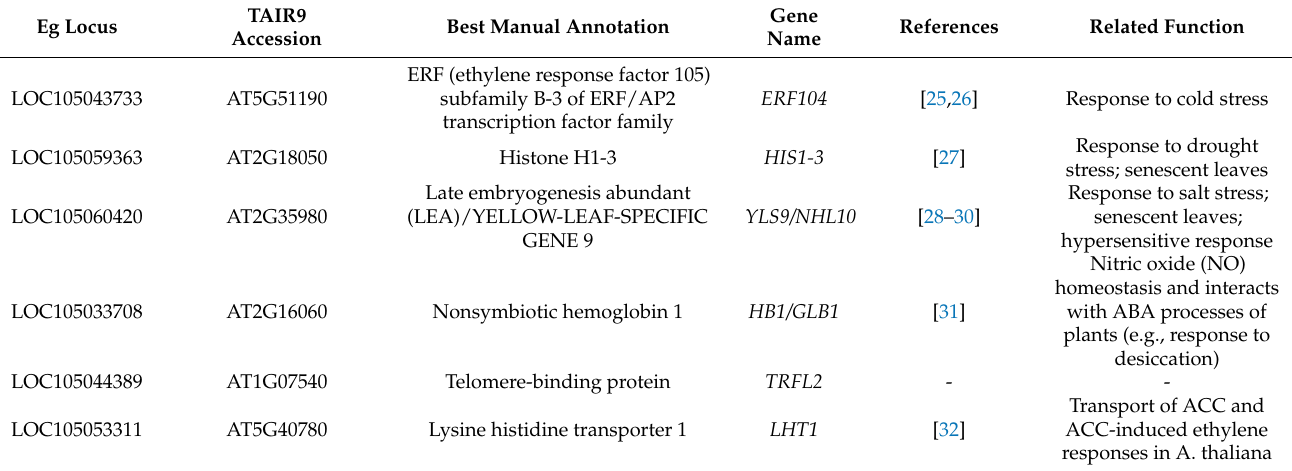
Table 1. Gene candidates identified in the current study that were also found in the previous transcriptome study with E. guineensis